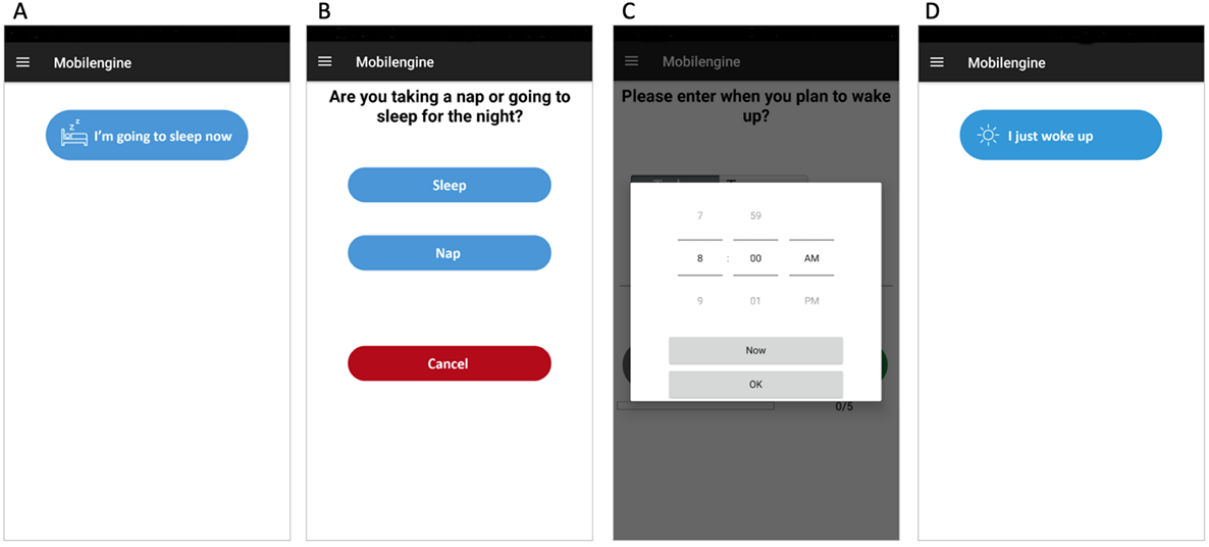
Figure 3. Sample screens for the sleep diary module. Sleep diary is activated by tapping on the “I’m going to sleep now” icon (A). Then, the user is prompted to indicate whether they were taking a nap or going to sleep for the night (B), as well as their intended wake-up time (C). Upon awakening, the user selects the “I just woke up” icon